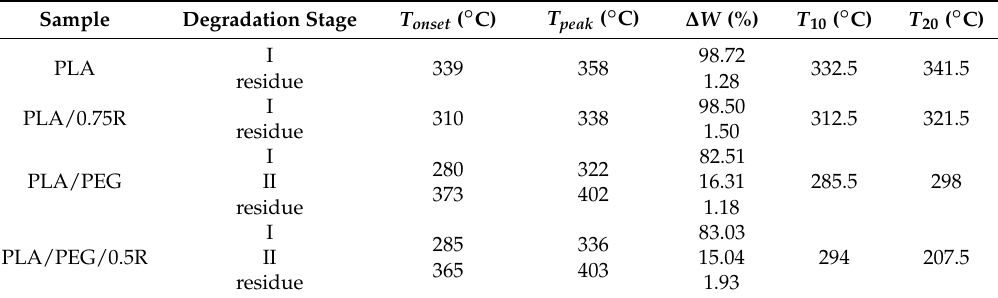
Figure 9. TG/DTG curves of the PLA, PLA/R, and PLA/PEG/R systems. Table 6. TG data for PLA containing powdered rosemary ethanolic extract.